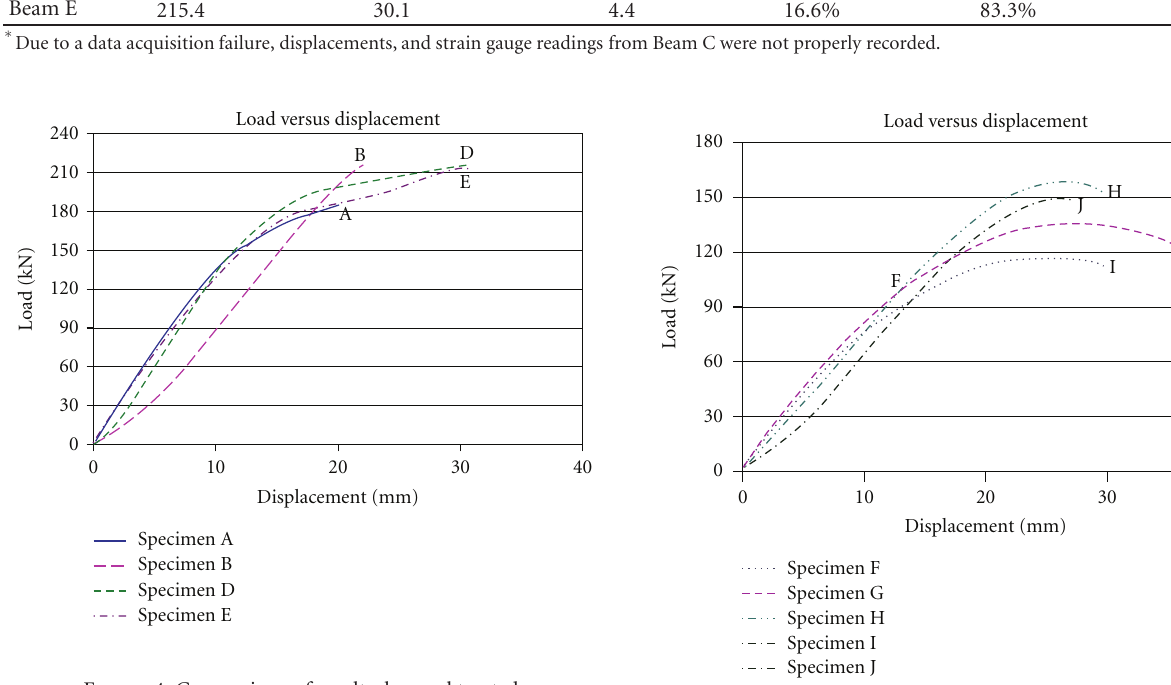
Figure 5: Comparison of results: